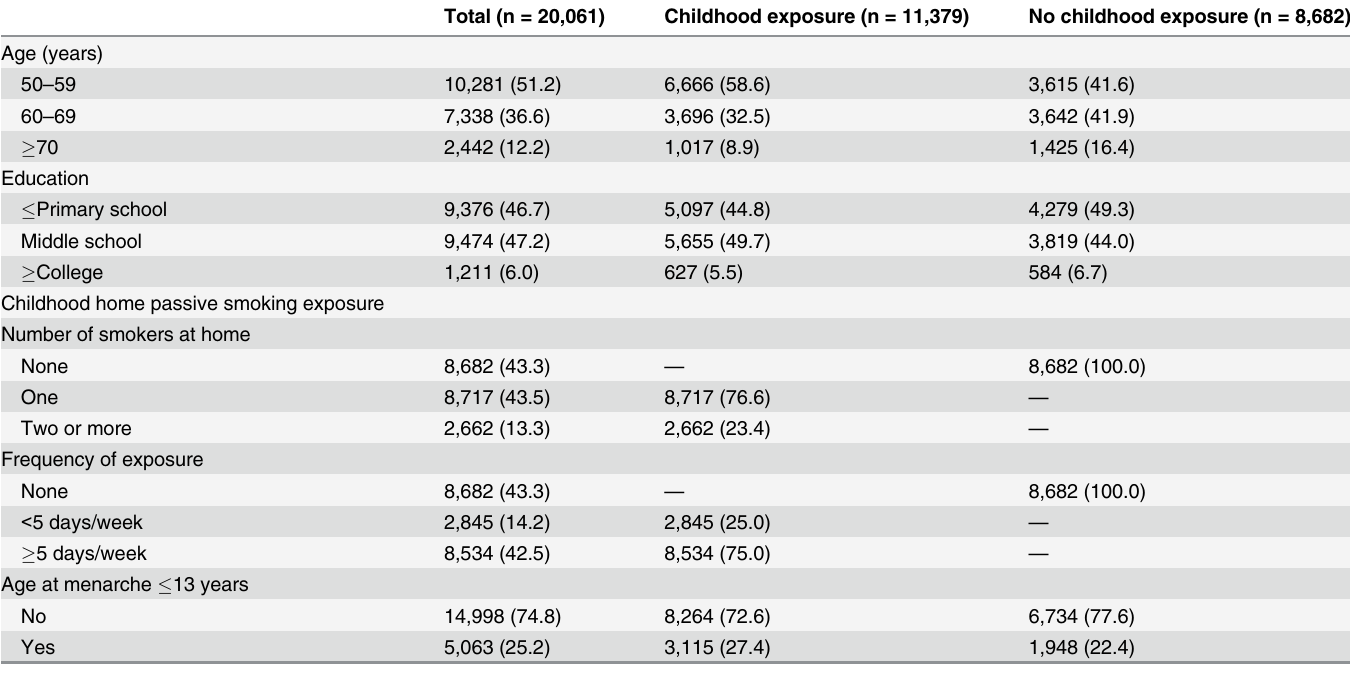
Table 1. Baseline characteristics of female participants who had never